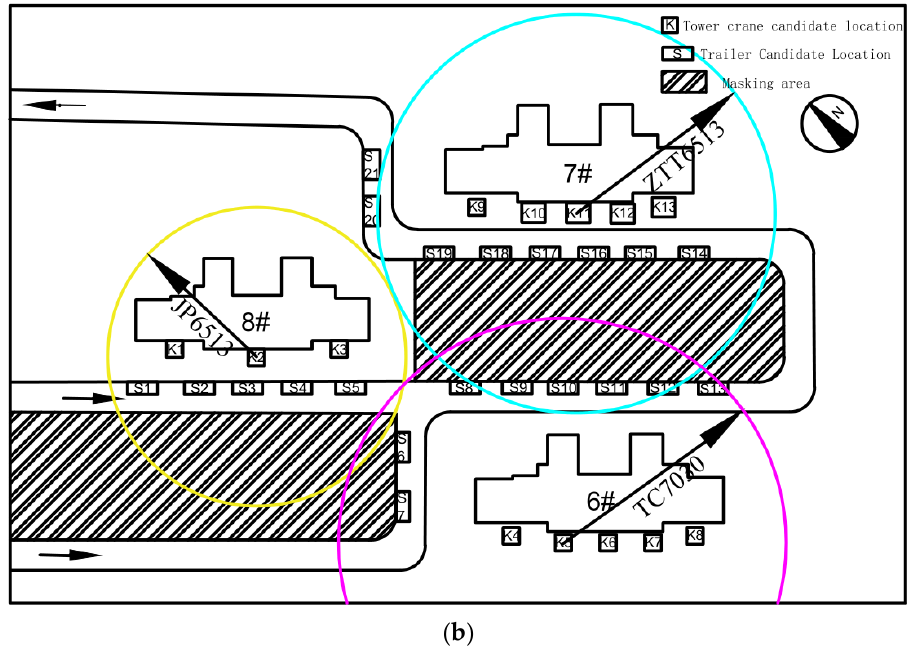
Figure 7. ( a ) Tower crane arrangement before optimization; ( b ) optimized tower crane arrangement diagram.